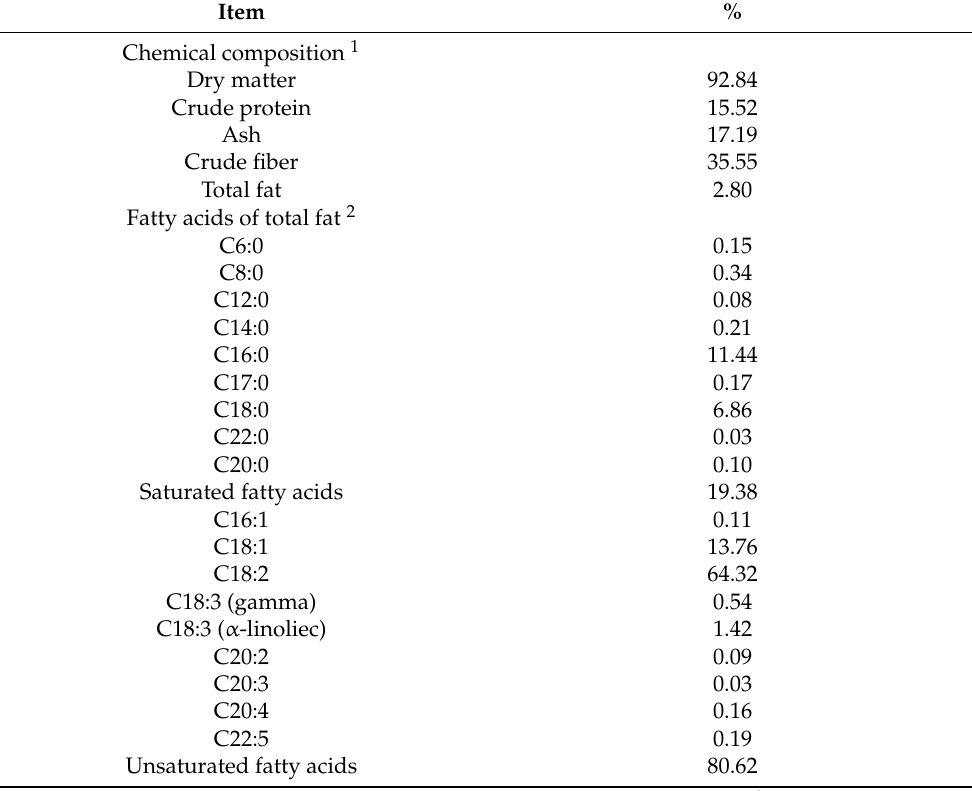
Table 2. Nutritional values and fatty acids composition of Tribulus Terrestris (TT).